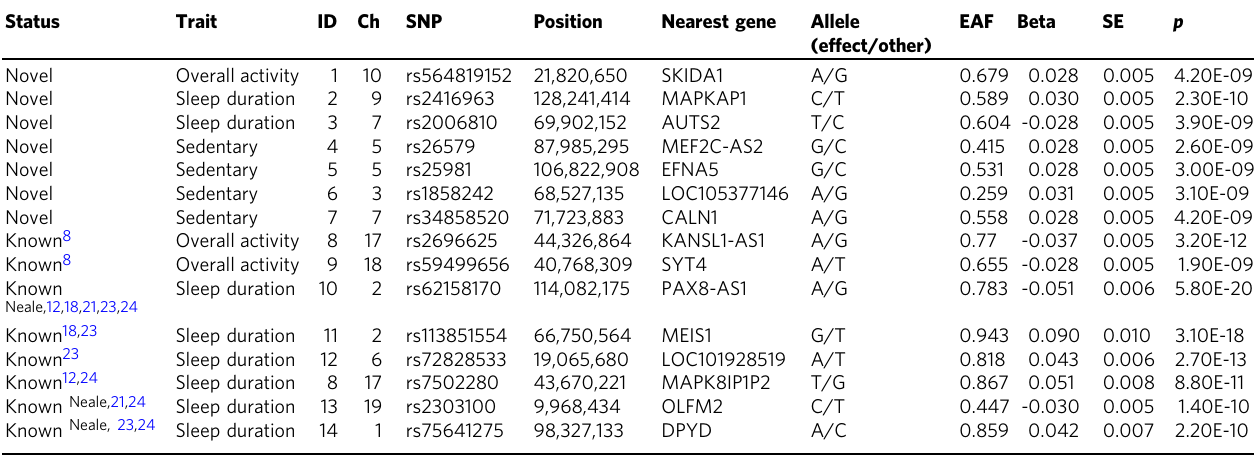
Table 1 Genome-wide signi fi cant (5 × 10 − 9 ) loci associated with accelerometer-measured physical activity and sleep duration behaviours in 91,105 UK Biobank